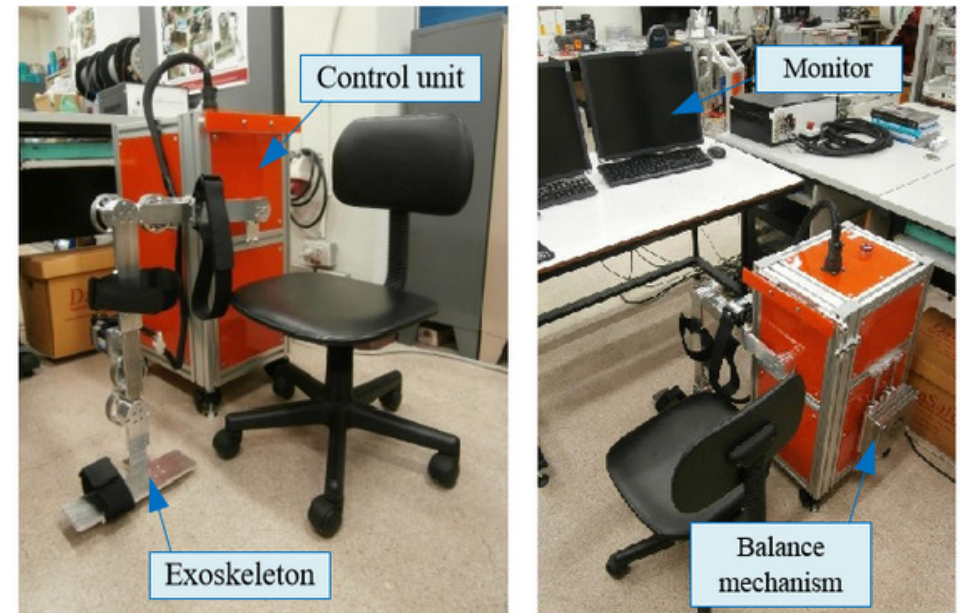
Figure 4. A sitting rehabilitation training robot.